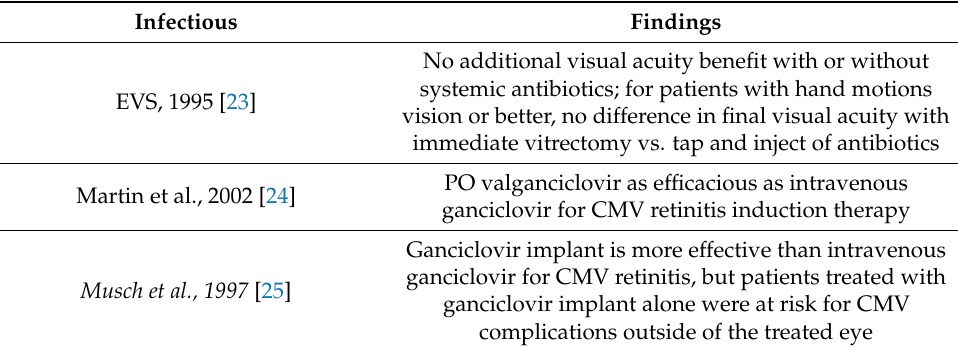
Table 3. Major randomized, controlled uveitis drug studies. CMV, cytomegalovirus; IM, intramuscu- lar; IV, intravitreal; IVT intravitreal triescence; ME, macular edema; PO, per os